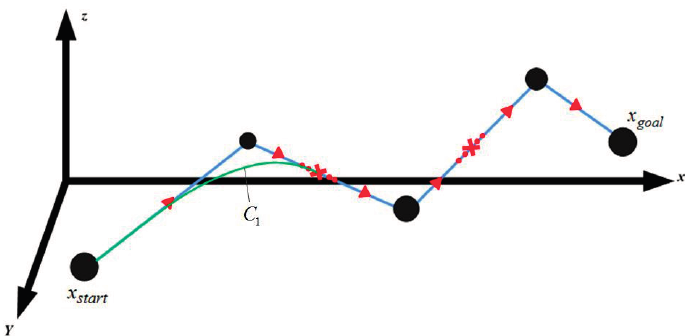
Figure 6. Positions of the control nodes.